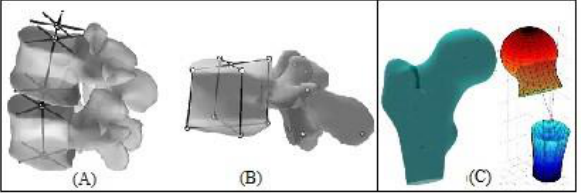
Fig. 4.(A) Parametric spine model (S. Humbert et al, 2009), (B) Parametric vertebra model for L4, (C) (left) MPPM,